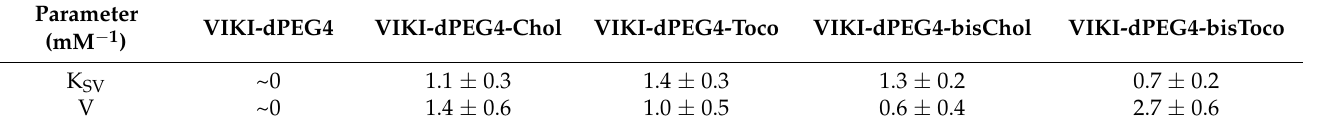
Table 2. Stern–Volmer constants (K SV ) and static constants (V) obtained for the peptides in POPC LUV, quenched by 16-NS, using Equation (4) (Stern–Volmer plots with positive deviation) to fit to the experimental data. Data are presented as the best-fit value from three independent experiments ±